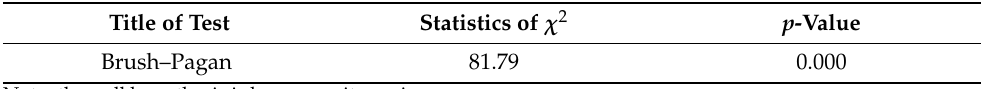
Table 18. The outcomes of the variance heterogeneity test of model two.